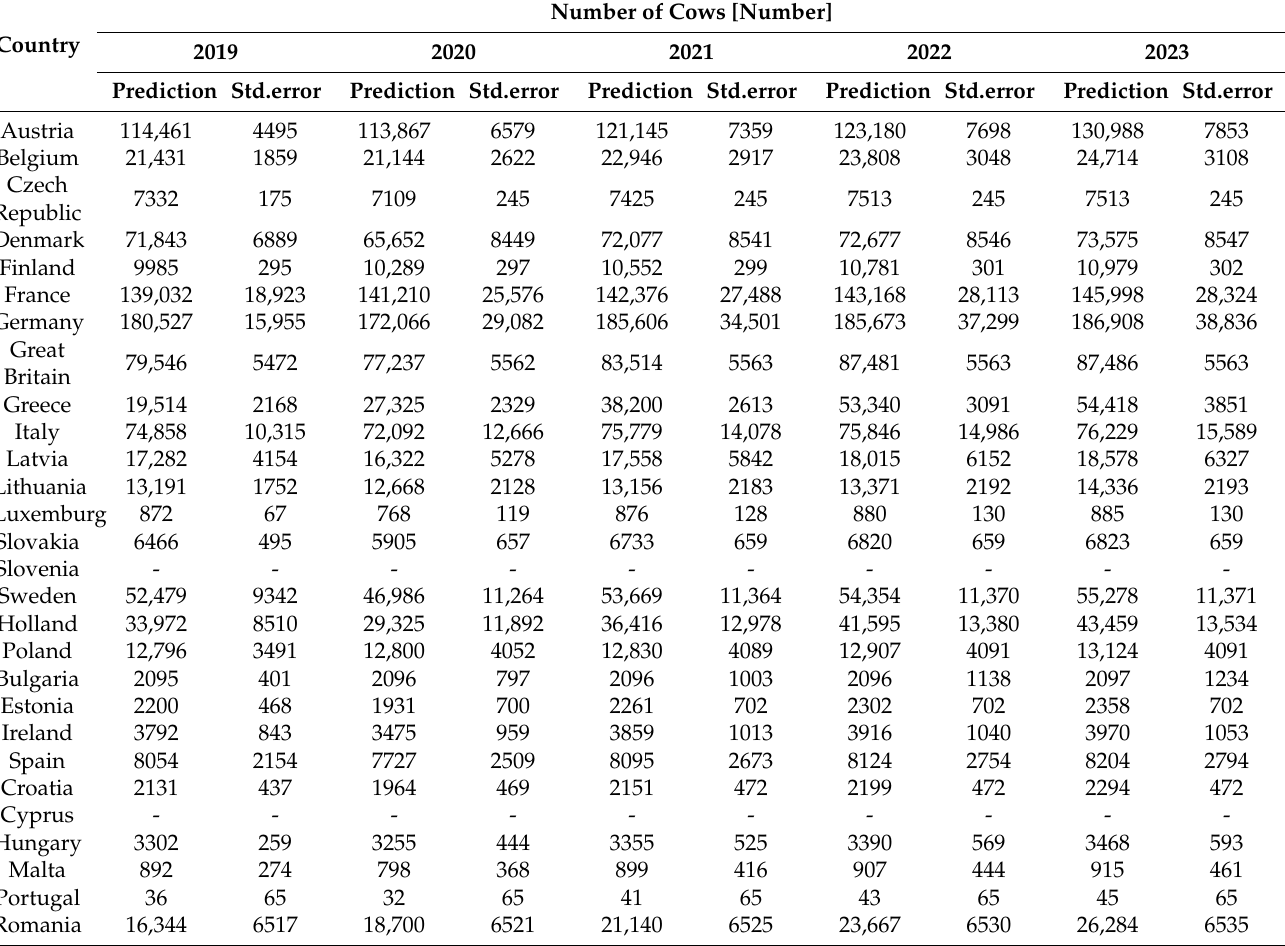
Table 3. Prognosis of cows in organic farms in the EU countries. Number of Cows [Number] Country Prediction Std.error Prediction Std.error Prediction Std.error Prediction Std.error